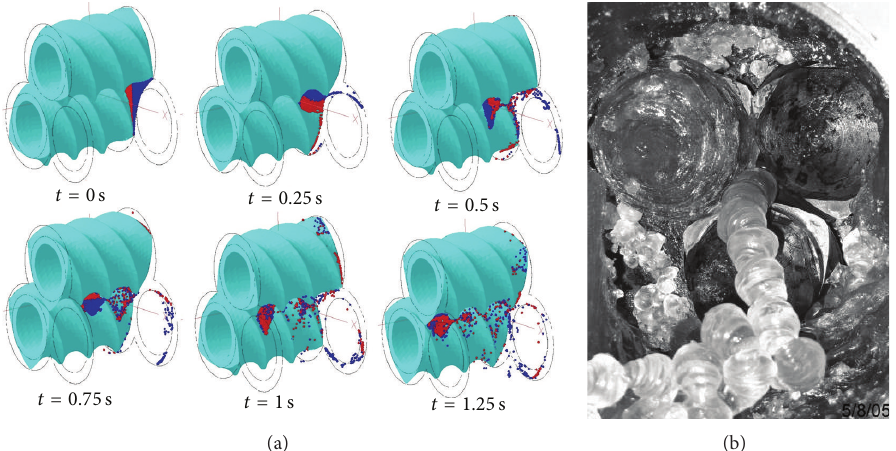
Figure 6: Particles conveying processing in the center region of the tri-screw extruder: (a) numerical results; (b) experiment results [11].